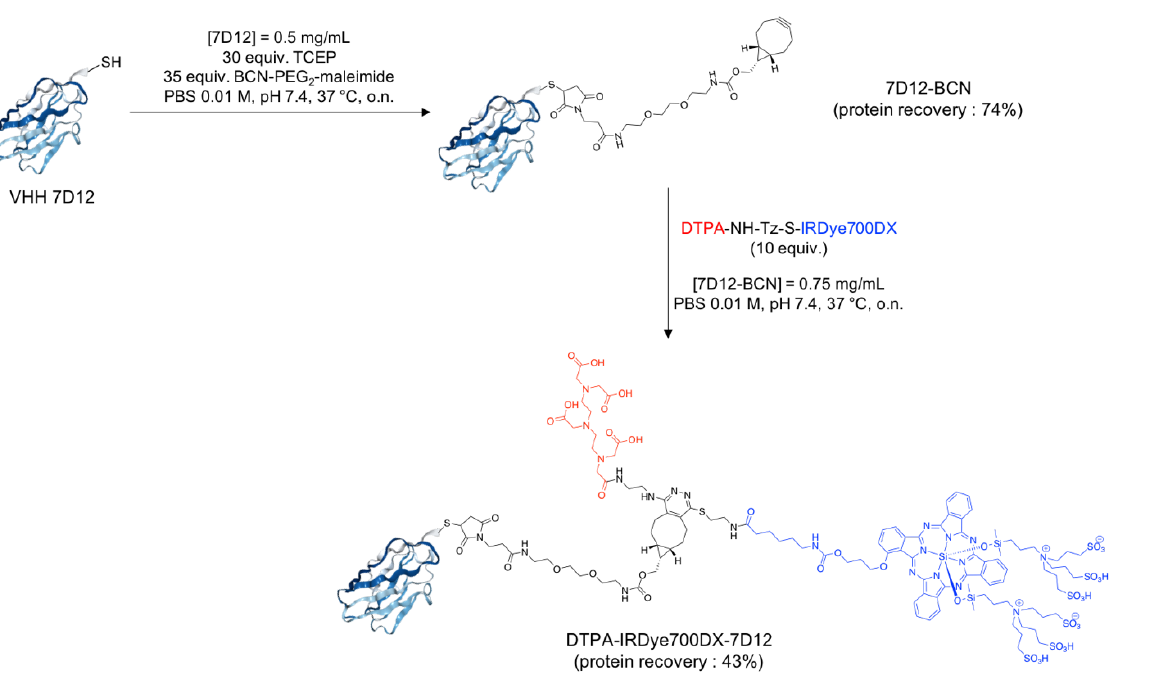
Figure 1. Synthesis of the bimodal conjugate DTPA-IRDye700DX-7D12.